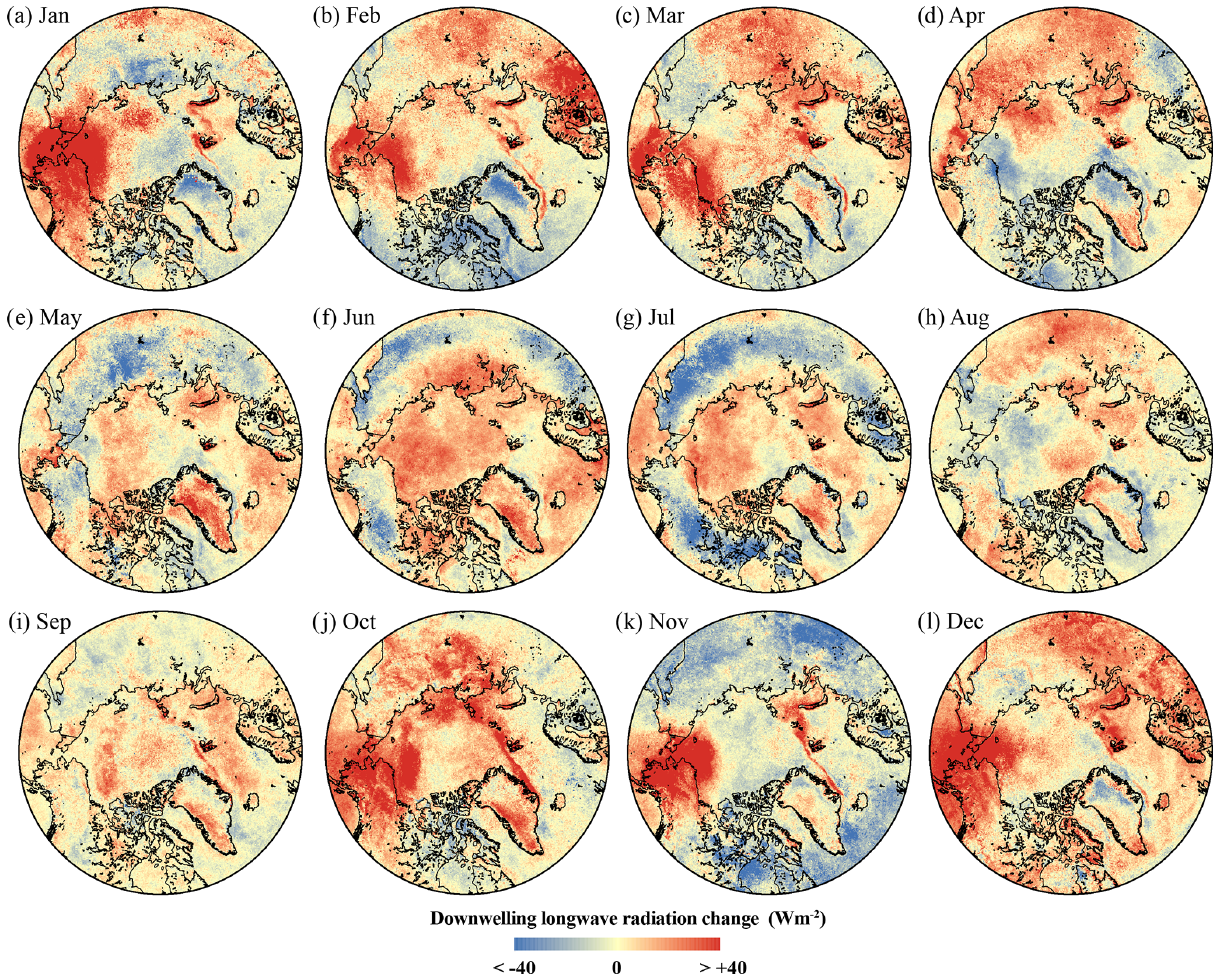
Figure 9. Trends in downwelling longwave radiation 2004–2019 in (a) January, (b) February, (c) March, (d) April, (e) May, (f) June, (g) July, (h) August, (i) September, (j) October, (k) November, and (l)